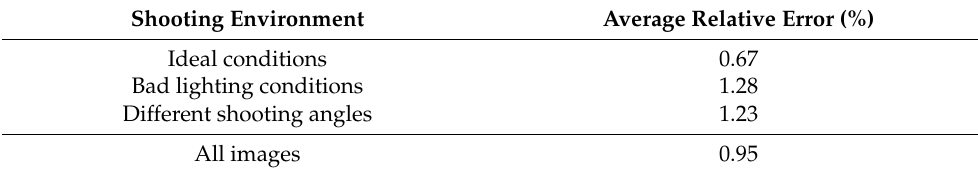
Table 2. Average relative error for different shooting